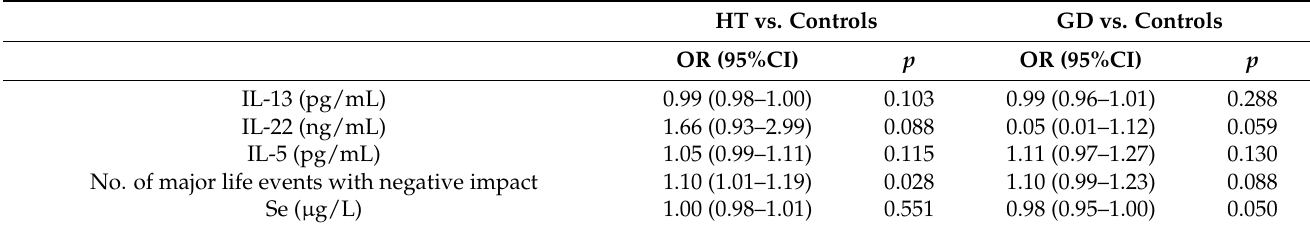
Table 4. Odds ratio of AITDs in association with selected cytokines, the number of negative major life events, and serum selenium: multiple regression model. HT vs.